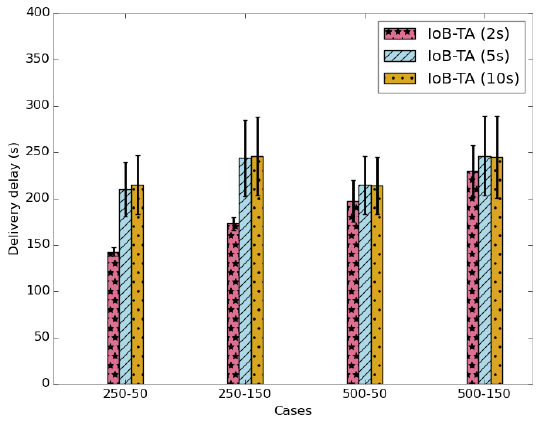
Figure 31. Average delivery delay for IoB-TA.